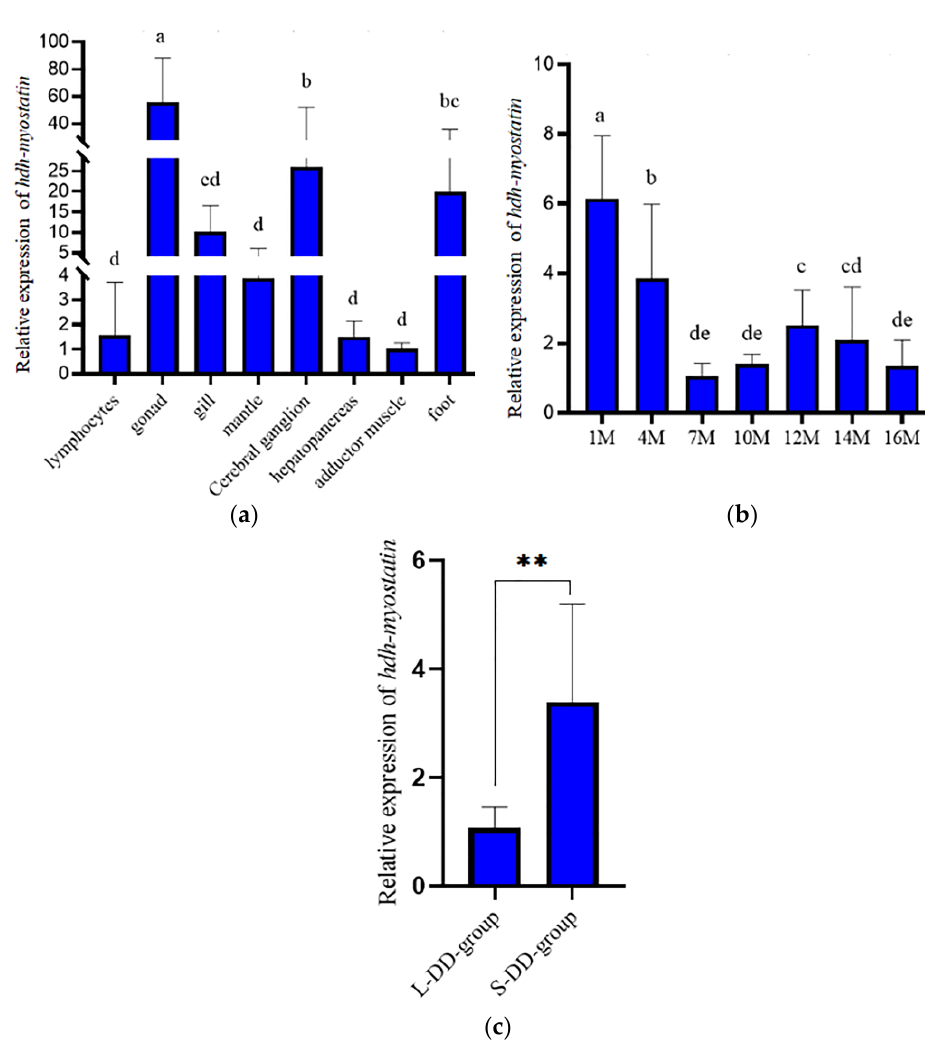
Figure 4. Expression pattern of hdh-myostatin from H. discus hannai . ( a ) Expression pattern of hdh-myostatin during various tissues. ( b ) Expression pattern of hdh-myostatin during development. ( c ) Expression pattern of hdh-myostatin in the fast-growing (L-DD-group) and slow-growing (S-DD-group) groups. Bars with different letters indicate significant differences ( p < 0.05). ** indicate significant differences ( p < 0.01).